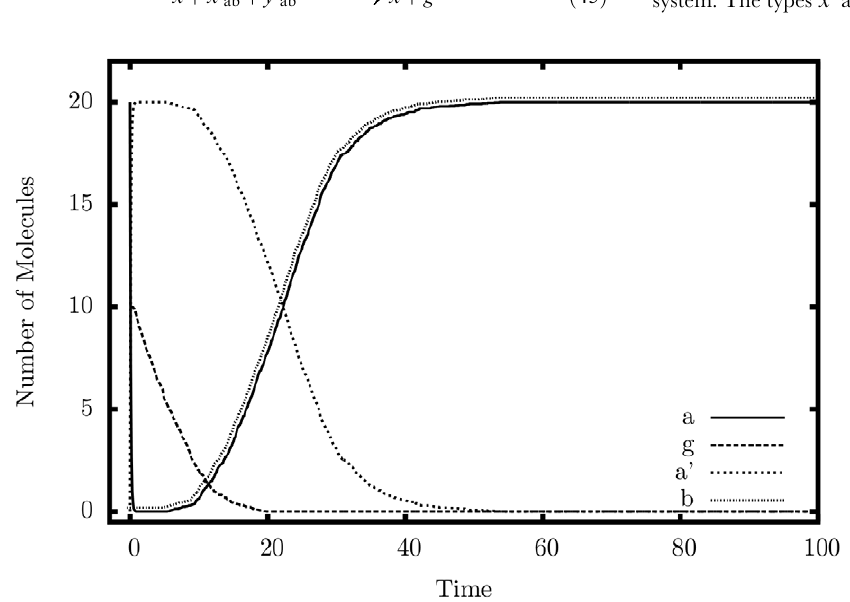
Figure 5. Simulation output of the copier construct. a ~ 20 , g ~ 10 .